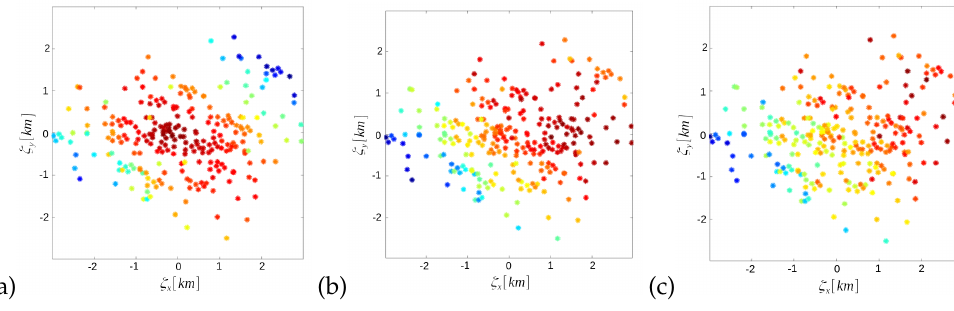
Figure 8. Correlation for subsequent time delays: ( a )—0; ( b )—10 s; ( c )—20